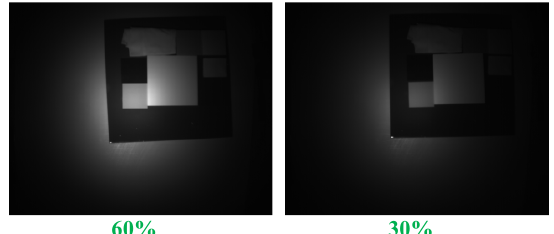
Figure 2. Imagery acquired with different exposure parameters ensuring 60% and 30% reflection from the grey reference panel top of the image).